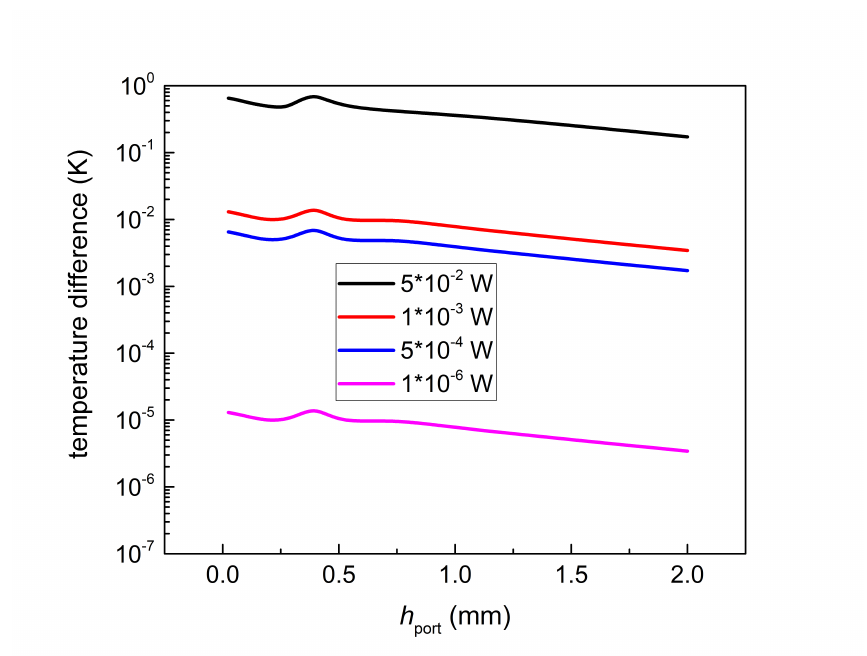
Figure 10. Temperature difference on h port at 0.5 THz; P ex values are listed in the legend. The responsivity of the antenna at different frequencies is presented in Figure 11. The dependence is nonlinear for all the frequencies and changes its value from 1 to 2.5 mVW − 1 . The responsivity at 0.3 THz has the lowest values, no higher than 1.5 mVW − 1 . The responsivity at 0.5 THz is the highest—from 1.25 to 2.5 mVW − 1 . No dependence of responsivity on the excitation power was observed.